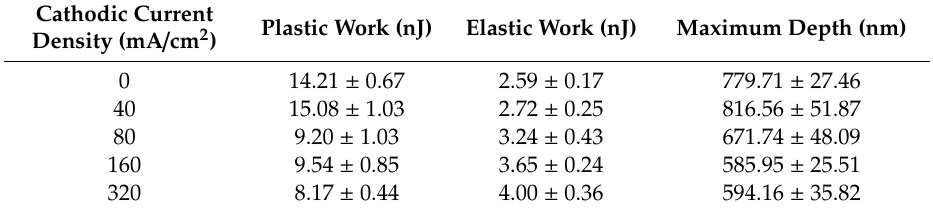
Figure 13. Hardness and reduced Young’s modulus vs. cathodic current density. The means and standard deviations based on ten independent measurements are shown. Table 2. Nanoindentation properties measured at different current densities.